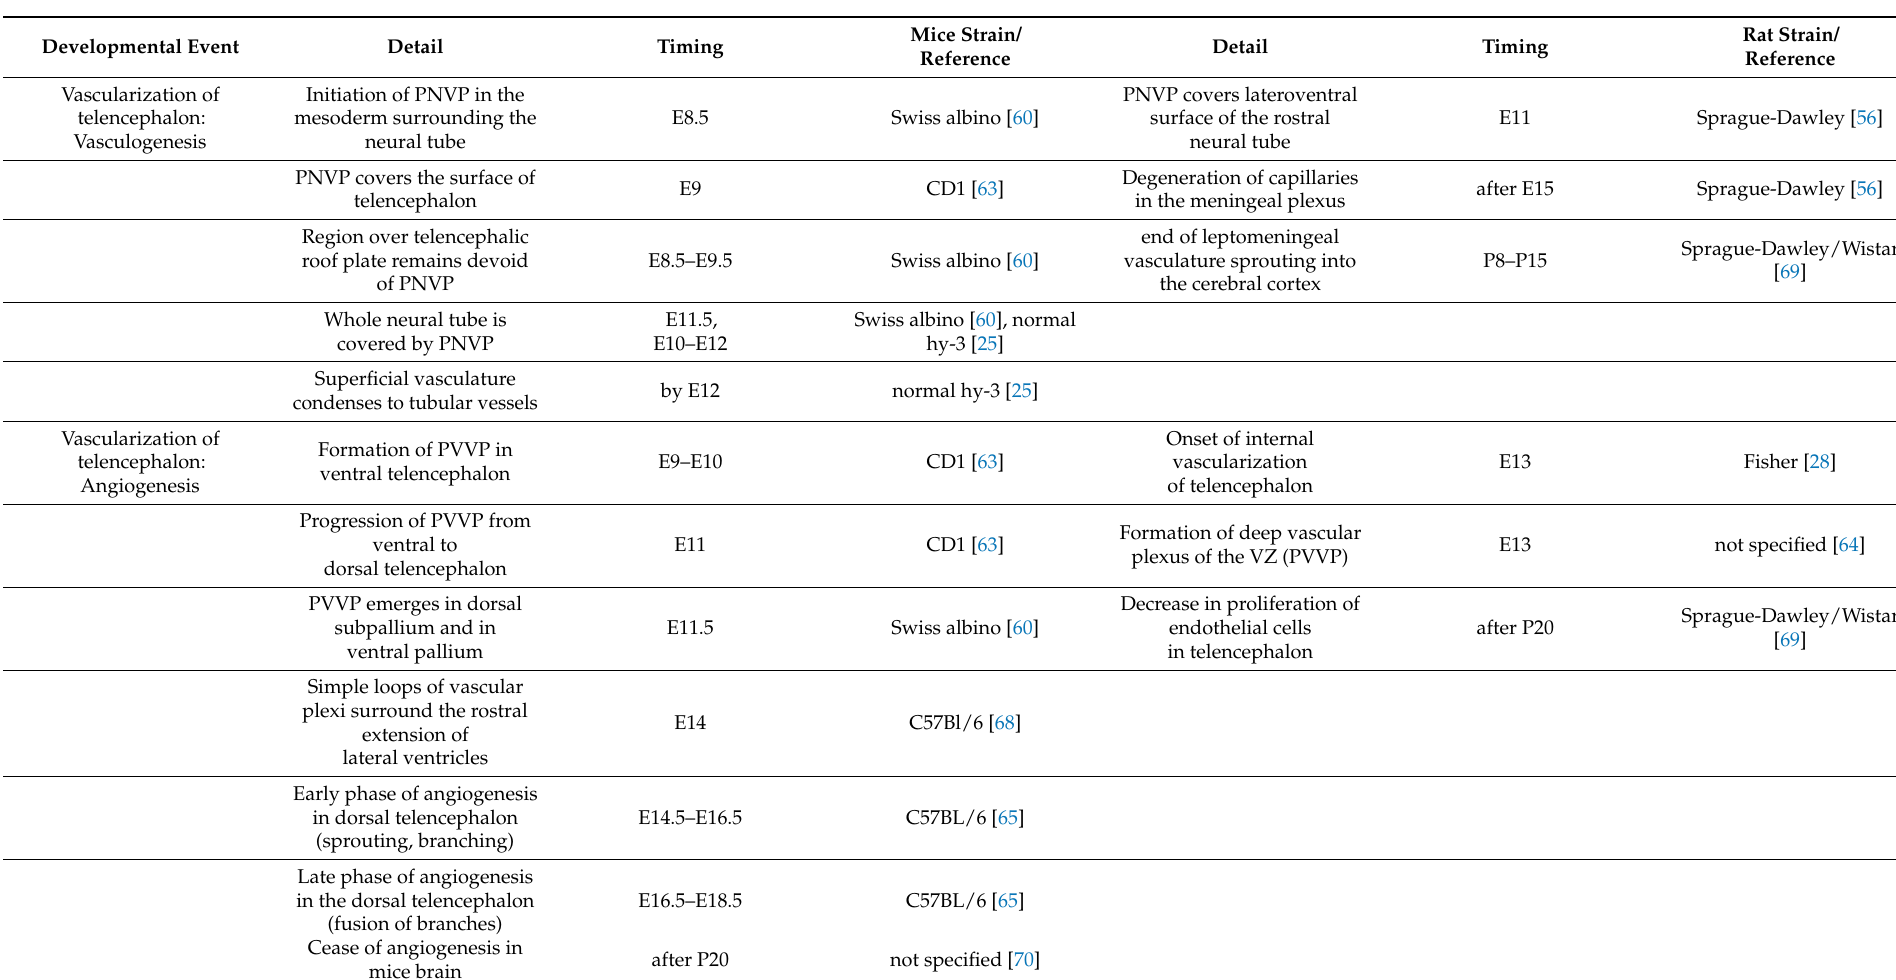
Table 2. Vascularization of telencephalon and